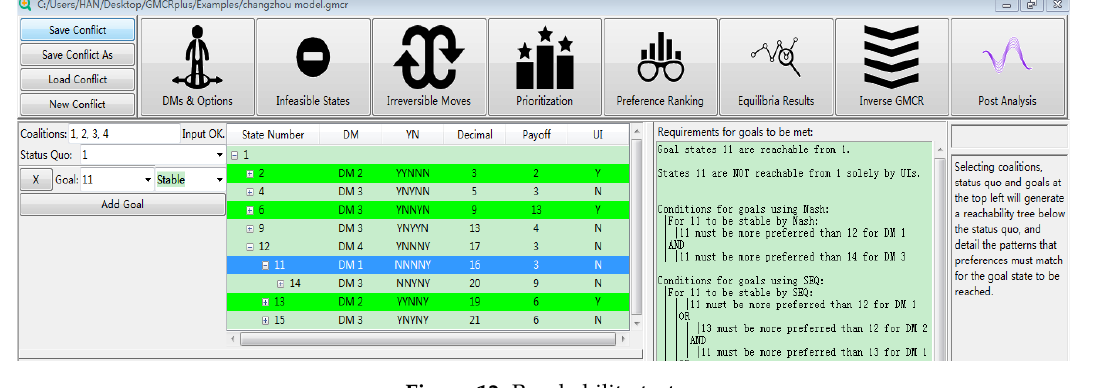
Figure 12. Reachability test.